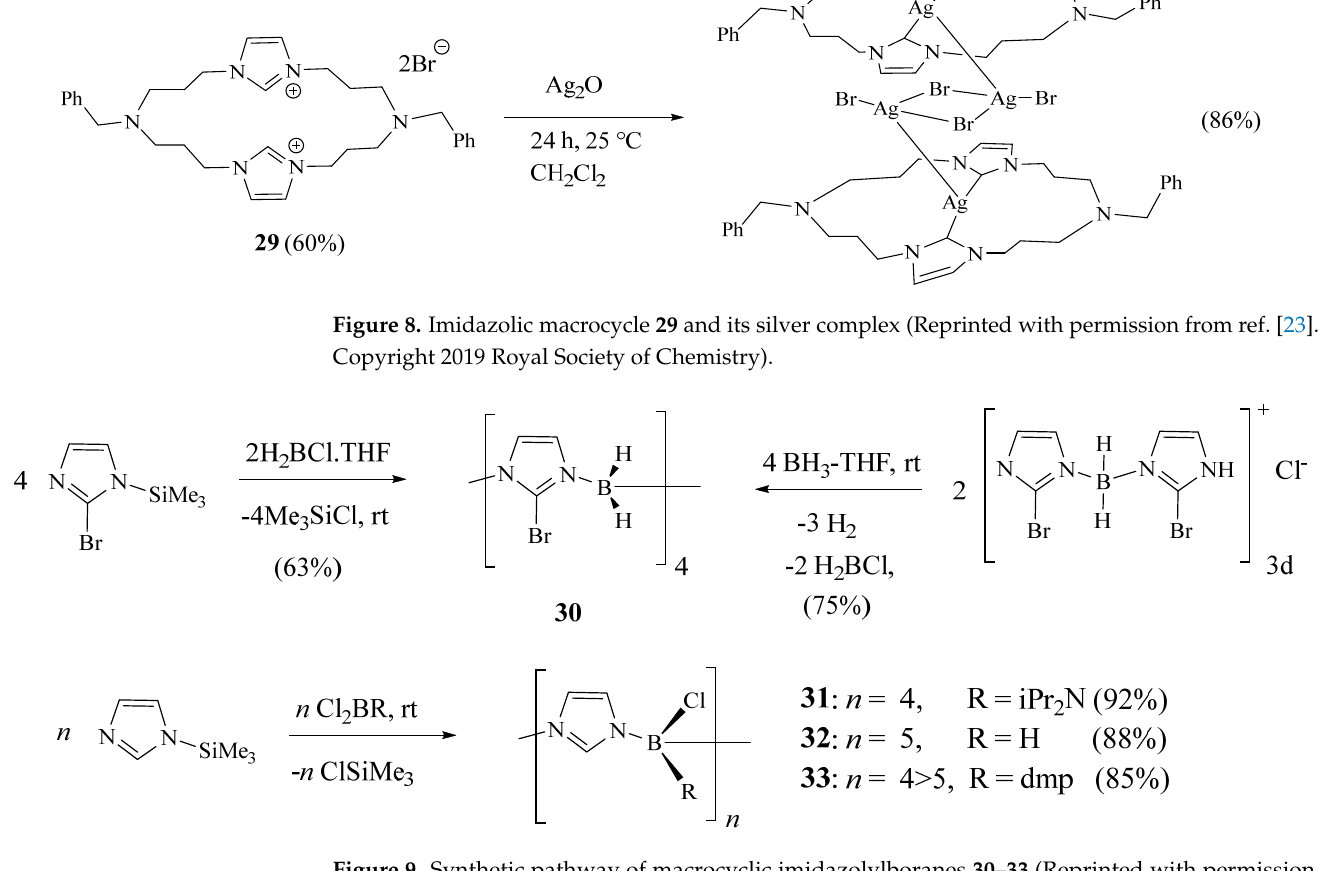
Figure 9. Synthetic pathway of macrocyclic imidazolylboranes 30 − 33. (Reprinted with permission from ref. [24]. Copyright 2003 Elsevier).